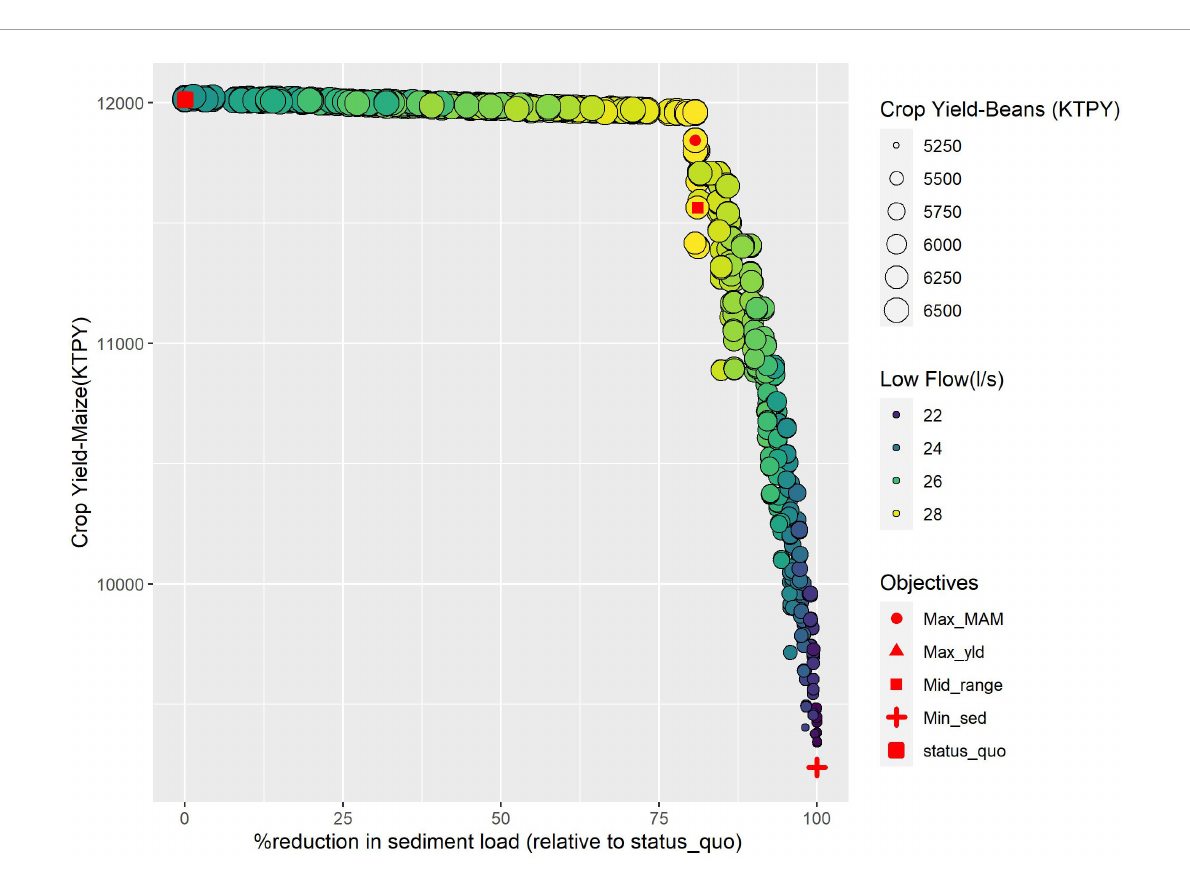
FIGURE4 Performance of the pareto solutions of scenario 2 for MAM, sediment load and crop yield objective